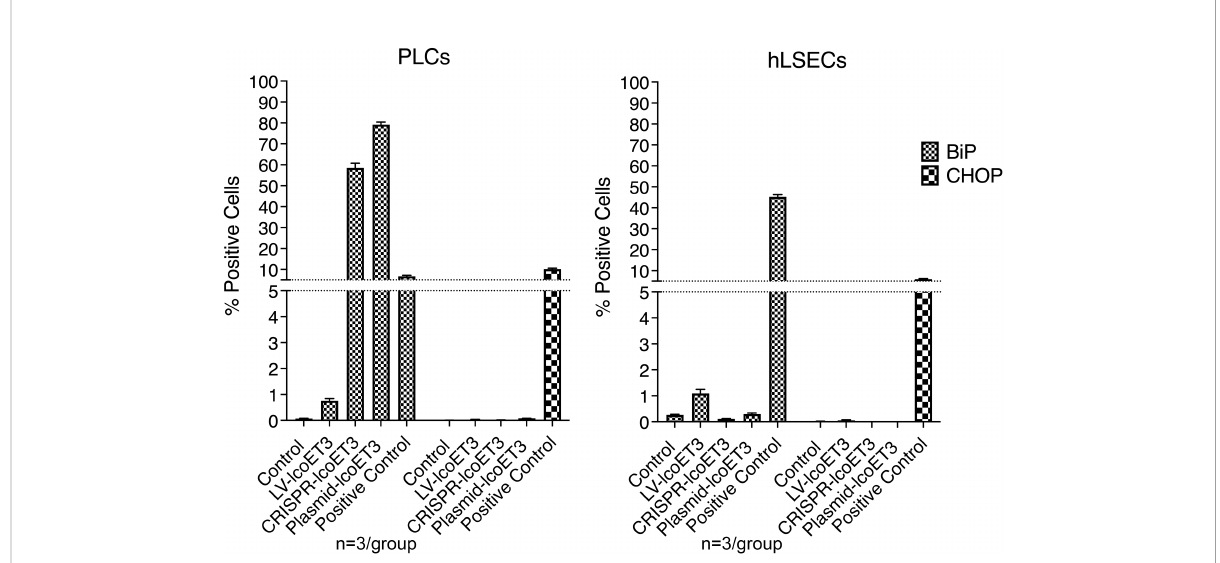
FIGURE 7 Flow cytometric analysis to quantify expression of ER stress molecules BiP and CHOP in unmodi fi ed and gene-modi fi ed PLCs (left panel) and hLSECs (right panel). Cells treated with tunicamycin were used as positive controls for ER stress. n=3/experimental group for each cell